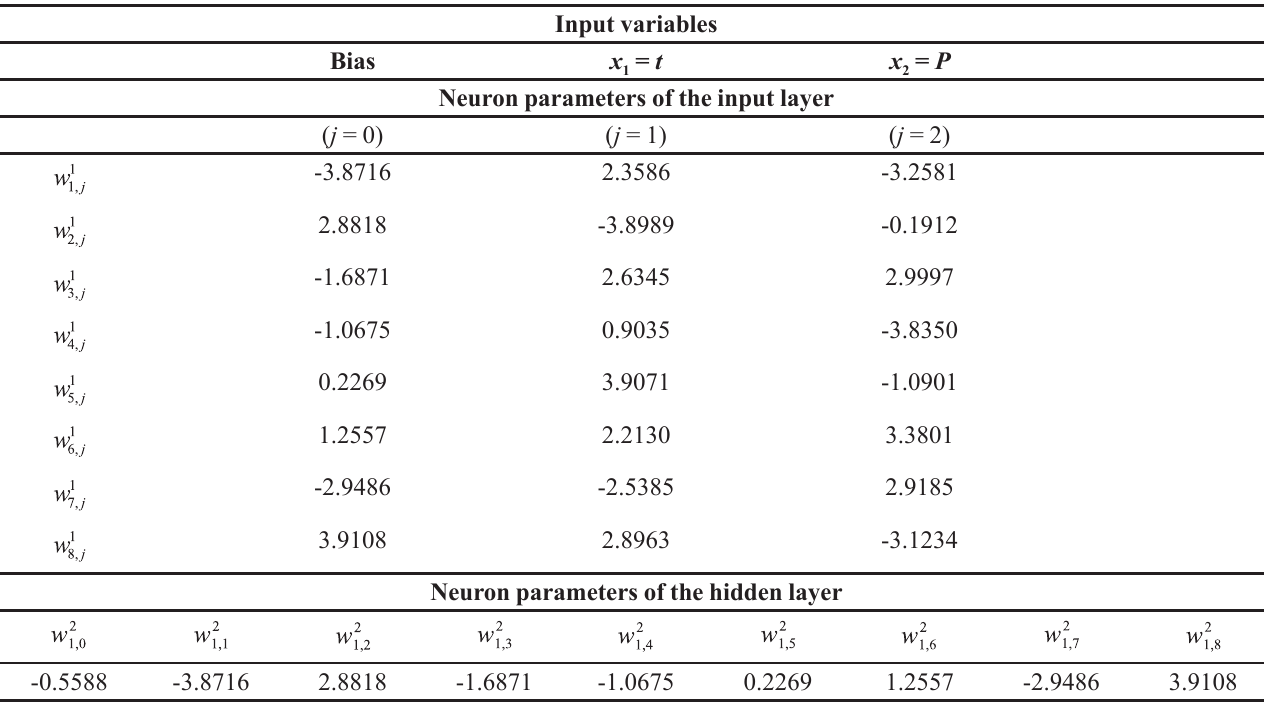
TABLE VIII - Parameters found for ANN associated to data in Table IV and Equation 4